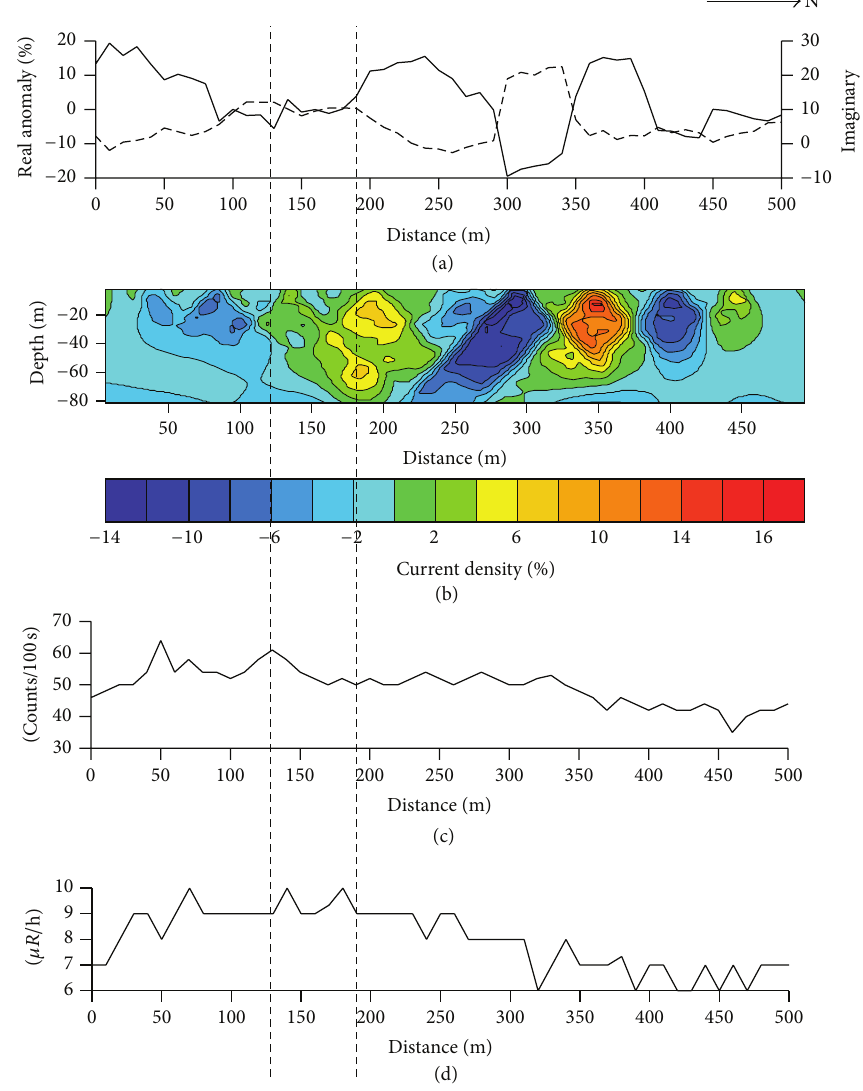
Figure 9: Profile P1800: (a) VLF anomaly (real by solid line and imaginary by dashed line), (b) pseudo current density cross-section along profile P1100, and (c) surface radiation and (d) surface gamma